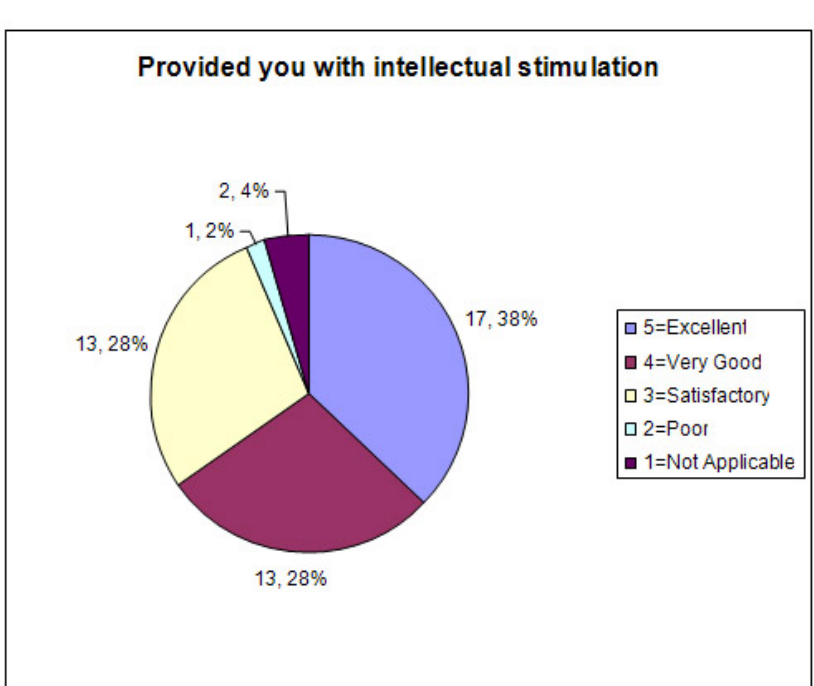
Figure 6. Mobile learning outcomes